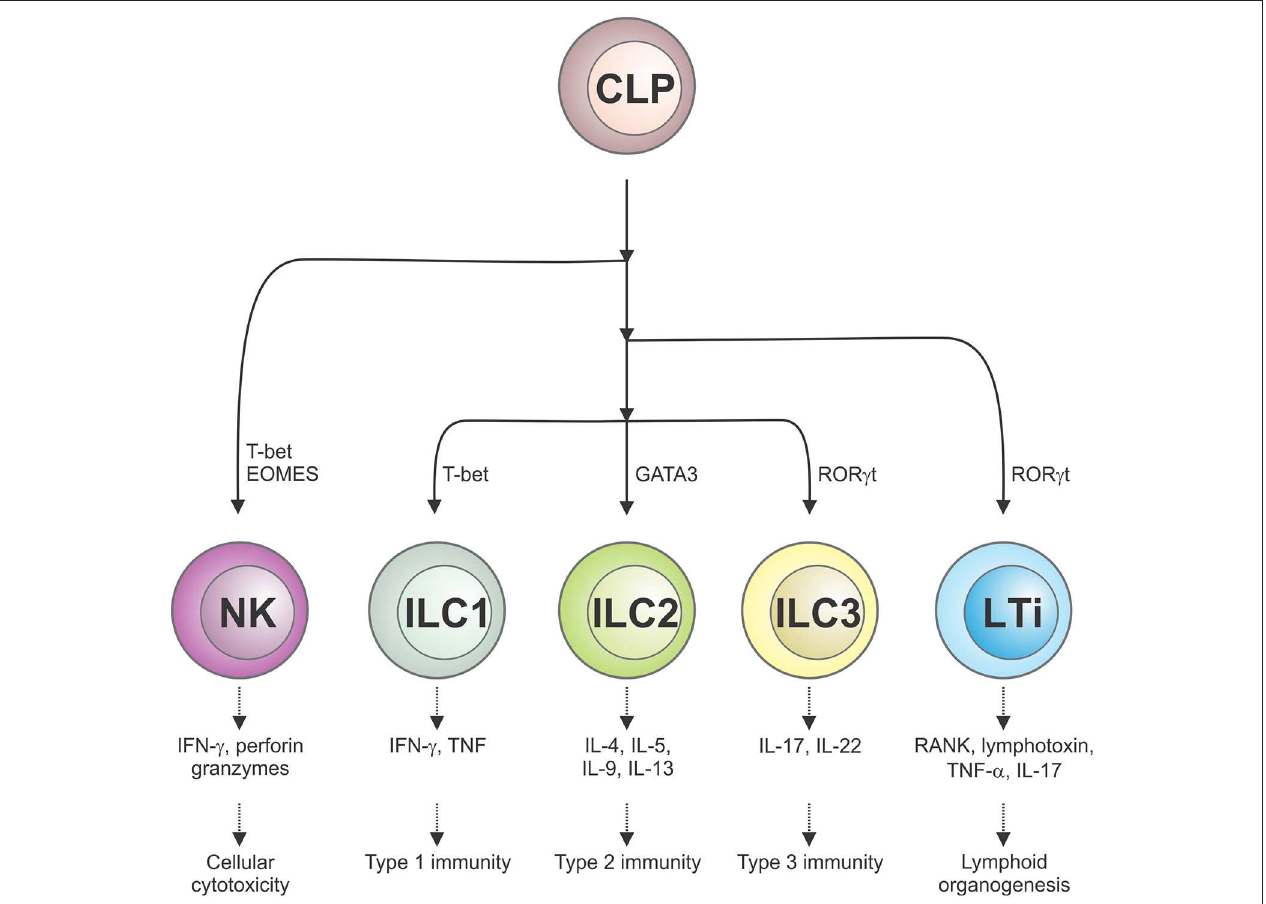
FIGURE 1 | Schematic representation of the five different ILC subsets and their roles in cellular immunity. ILCs, which are derived from a common lymphoid progenitor (CLP), are classified into five distinct subsets on the basis of their transcription factor usage and unique spectrum of cytokines that they produce. This confers their distinct roles in immune responses and lymphoid organ